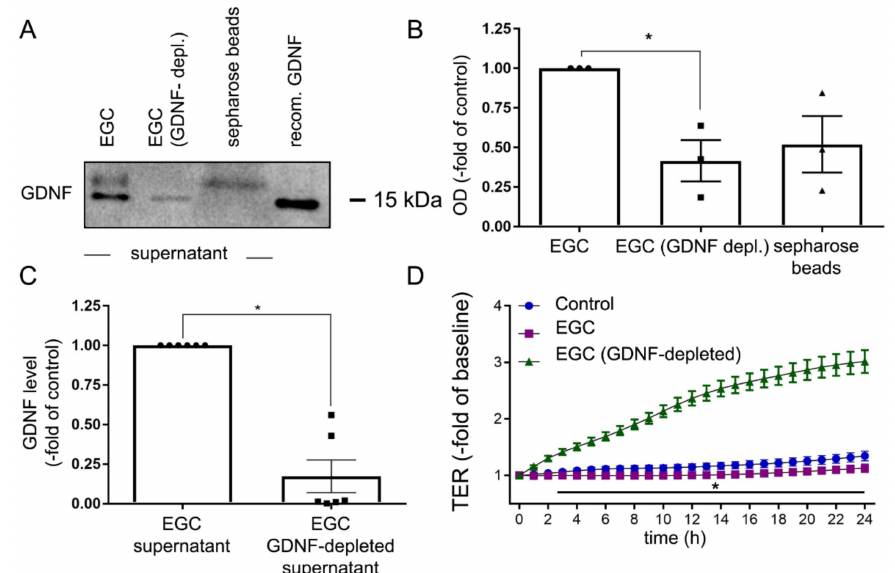
Figure 3. Depletion of glial cell line-derived neurotrophic factor (GDNF) attenuated effects of enteric glial cells (EGC) on enterocytes. ( A ). Representative Western blot is shown for GDNF with and without depletion of GDNF from EGC supernatants using sepharose beads and GDNF antibodies. Human recombinant GDNF served as a positive control ( n = 3). ( B ). Quantification of the western blot signal showed a significant reduction of GDNF concentration in the cell lysates following the incubation with sepharose beads ( n = 3, * = p < 0.05, Kruskal Wallis Test). Control = EGC supernatant. ( C ). ELISA- based measurements of the GDNF concentration in the supernatant showed a reduction of GDNF to 17 ± 10% after depletion with sepharose beads ( n = 6, p < 0.05 Wilcoxon signed-ranked test). ( D ). Measurements of transepithelial electric resistance (TER) on Caco2 monolayers demonstrated, that the effect of EGC supernatant after depletion of GDNF by sepharose beads was blunted, compared to EGC supernatants without depletion of GDNF ( n = 6, * = p < 0.05, two-way ANOVA). Control = Caco2 monolayer without